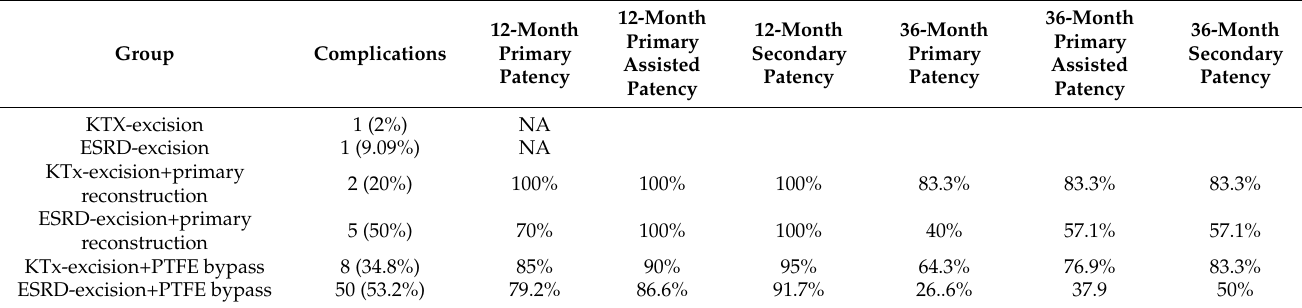
Table 5. Complications and patency rates in kidney recipient (KTx) and dialyzed control groups (ESRD) after dialysis fistula aneurysm excision, excision combined with primary reconstruction, excision combined with PTFE bypass.